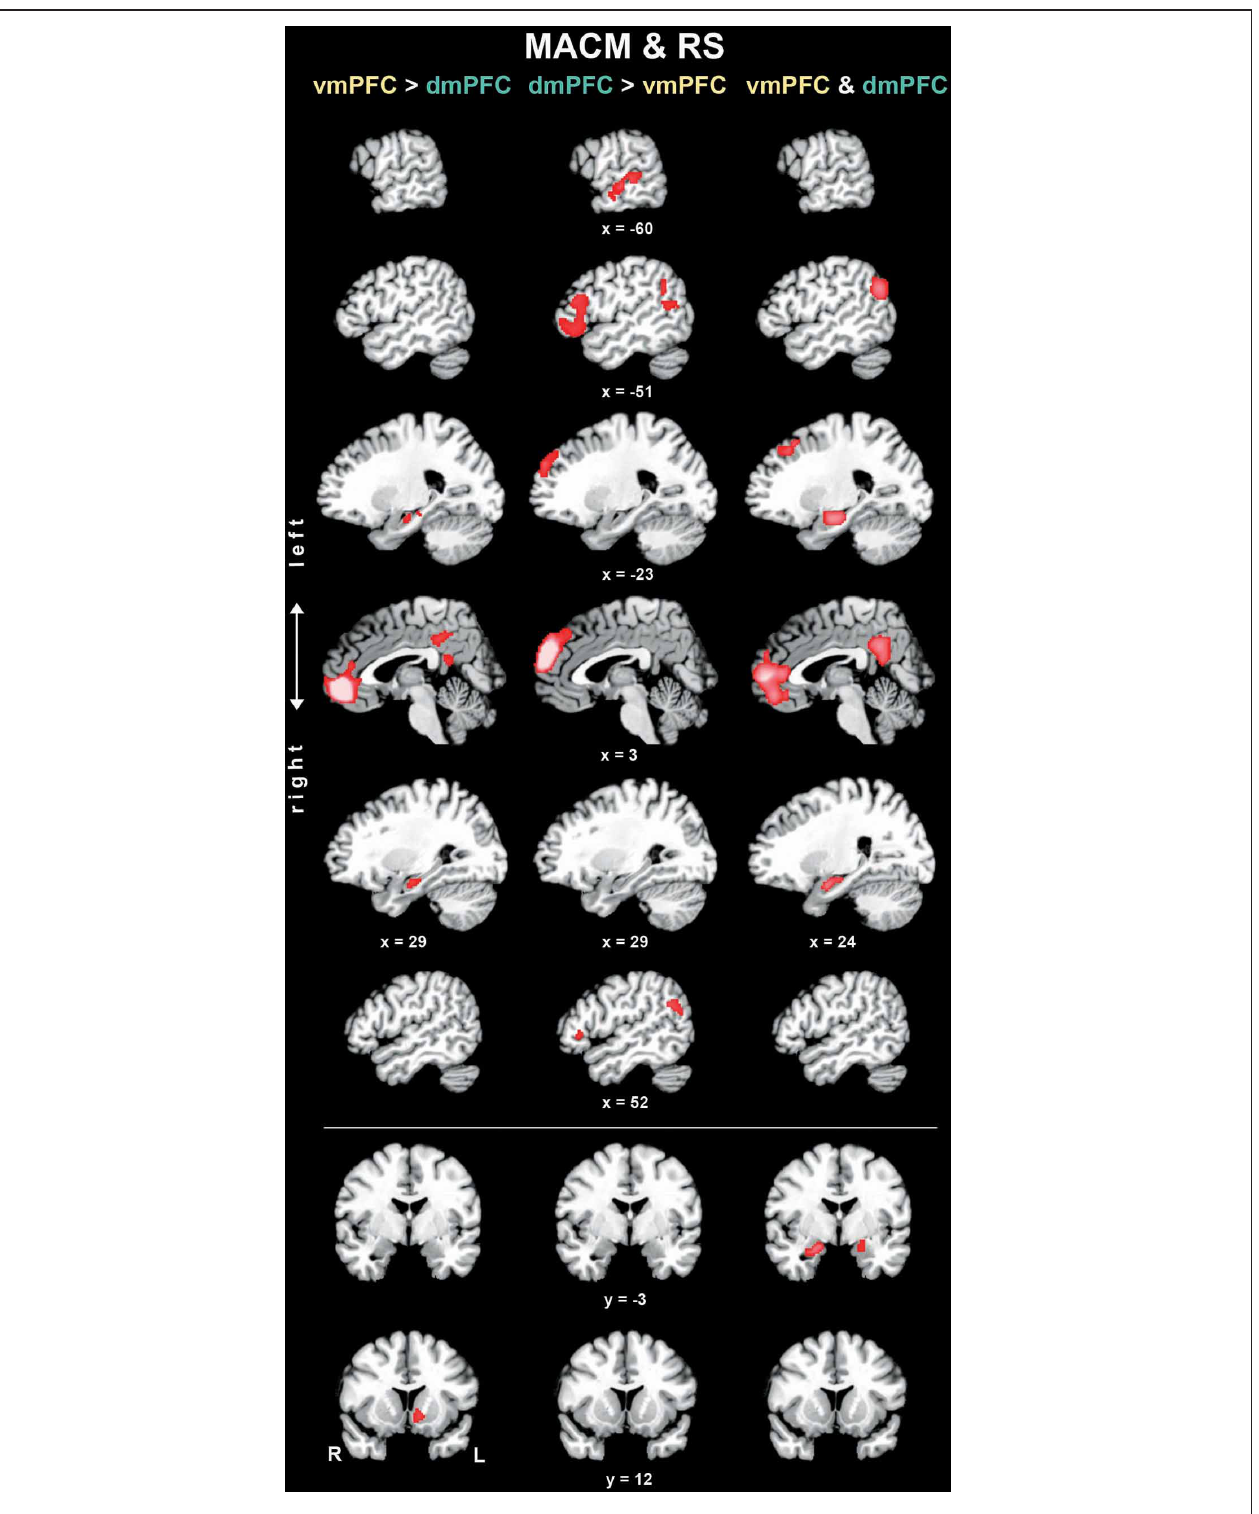
FIGURE 4 | Difference and conjunction analyses based on congruent functional connectivity of the vmPFC and dmPFC seeds. Depicts sagittal and coronal brain slices of areas consistently more strongly coupled (left and middle column) with either seed or congruently coupled with both seeds (right column) across meta-analytic connectivity modeling (MACM) and